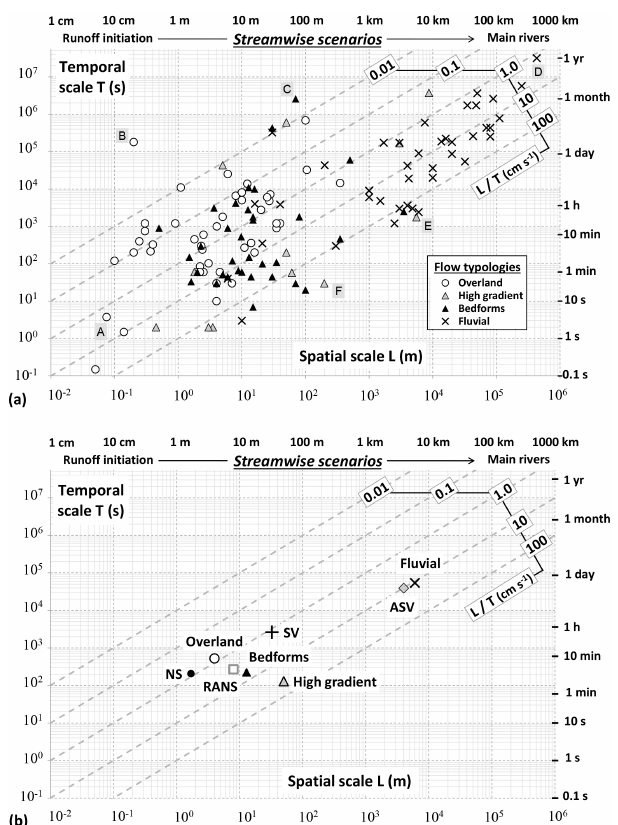
Figure 7. Position of the flow typologies in the ( L , H ) plane for the studies listed in Appendix A, selecting six textbook cases (sketches A to F, Table 1) for illustration (a) . Median positions for the choice of free-surface flow models (Navier–Stokes: NS; Reynolds- averaged Navier–Stokes: RANS; Saint-Venant: SV; or approxima- tions to Saint-Venant: ASV) and the study of flow typologies (Over- land, High-gradient, Bedforms, or Fluvial) across scales in the ( L , H ) plane (b) . A transverse analysis involves forming H/L ratios, searching for clues to model selection according to these “fine- nesses” of the flow domain or governed by flow typologies that would exhibit specific H/L